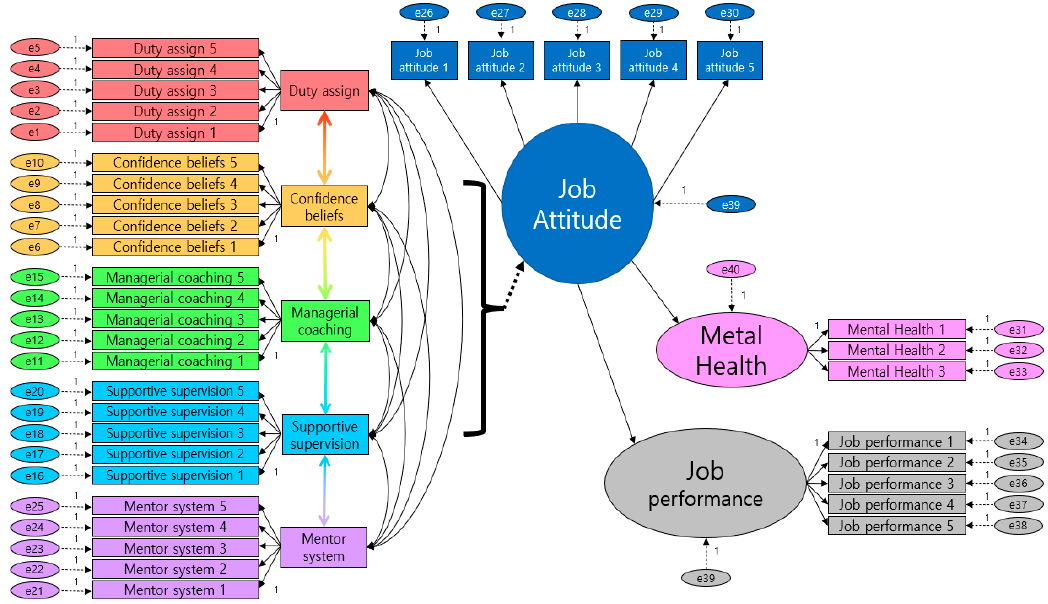
Figure 3. Structural Equation Model.